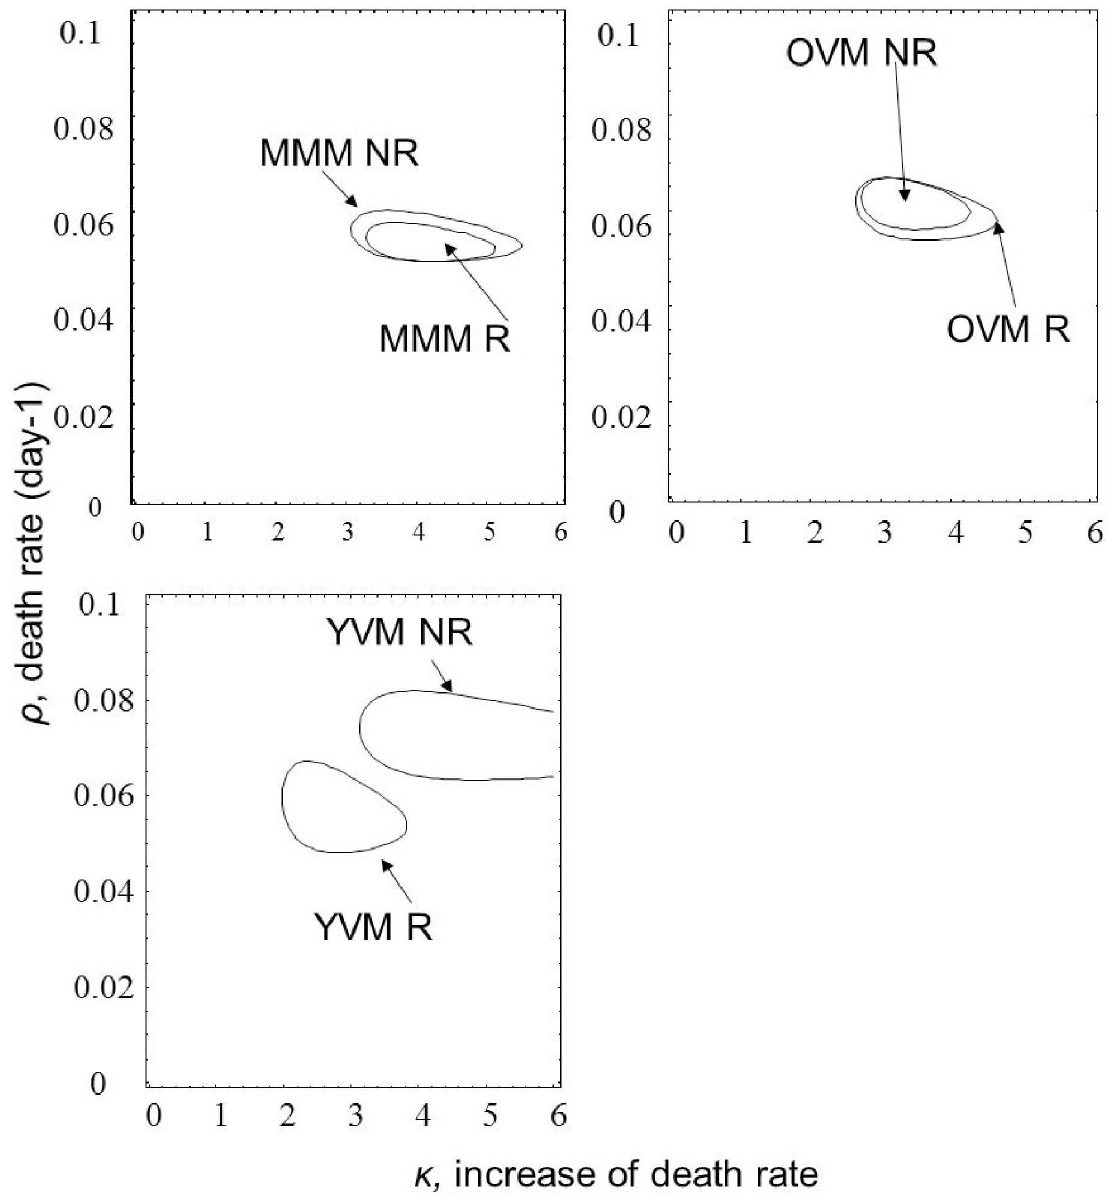
Fig 3. Fitted parameters for Weibull mortality function for Ostrinia nubilalis females that mated first 1) with a young virgin male and didn’t remate(YVM-NR) or did remate(YVM-R), 2) with an old (9 days old) virgin male and didn’t remate (OVM-NR) or did remate (OVM-R) and 3) with a multiple mated male and didn’t remate (MMM-NR) or did remate (MMM-R). The lines enclose 95% confidenceregions for the joint parameter estimates.